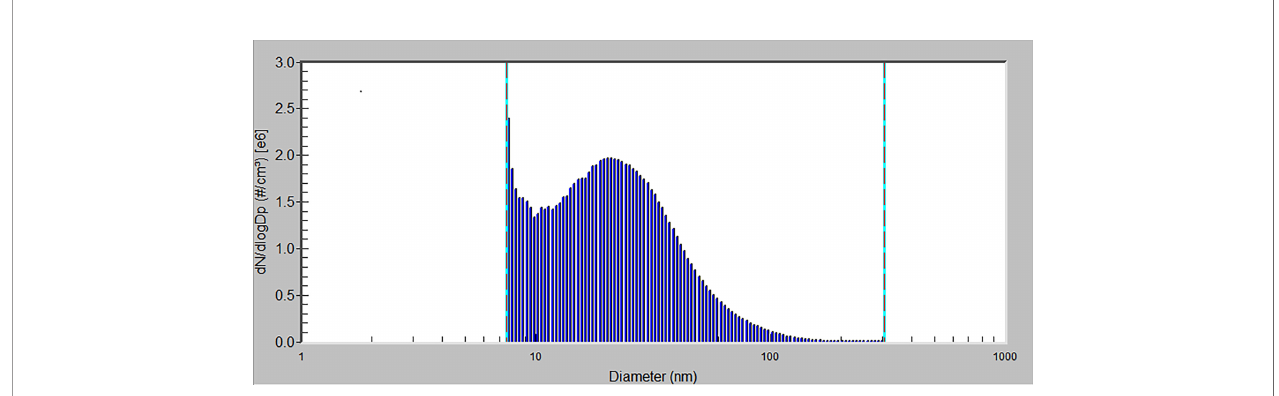
FIGURE 2 | The size distribution of CuO NPs by number. x-axis – particle diameter (a logarithmic scale), y-axis – number concentration of particles (the number concentration is normalized by the size range of particles) by